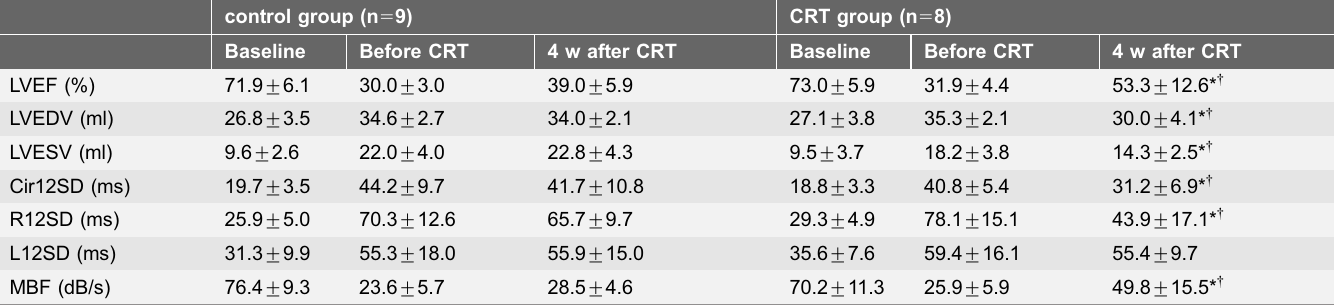
Table 1. The echocardiographic parameters of the two groups at baseline, before, and after